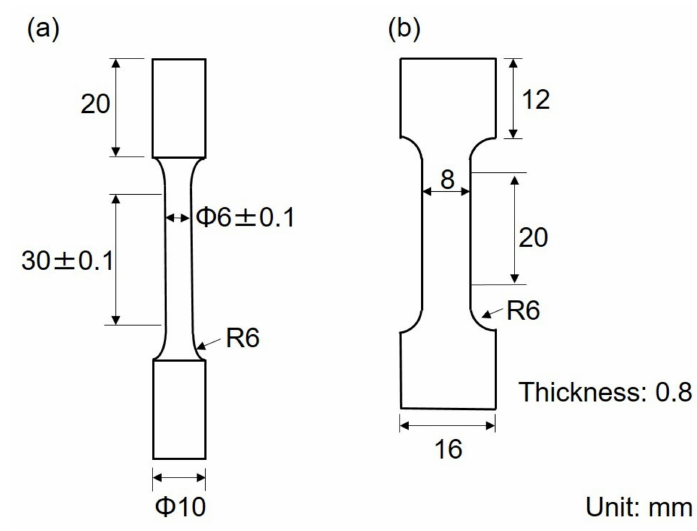
Figure 3. Key dimensions of the ( a ) circular tensile specimen and ( b ) thin plate specimen.